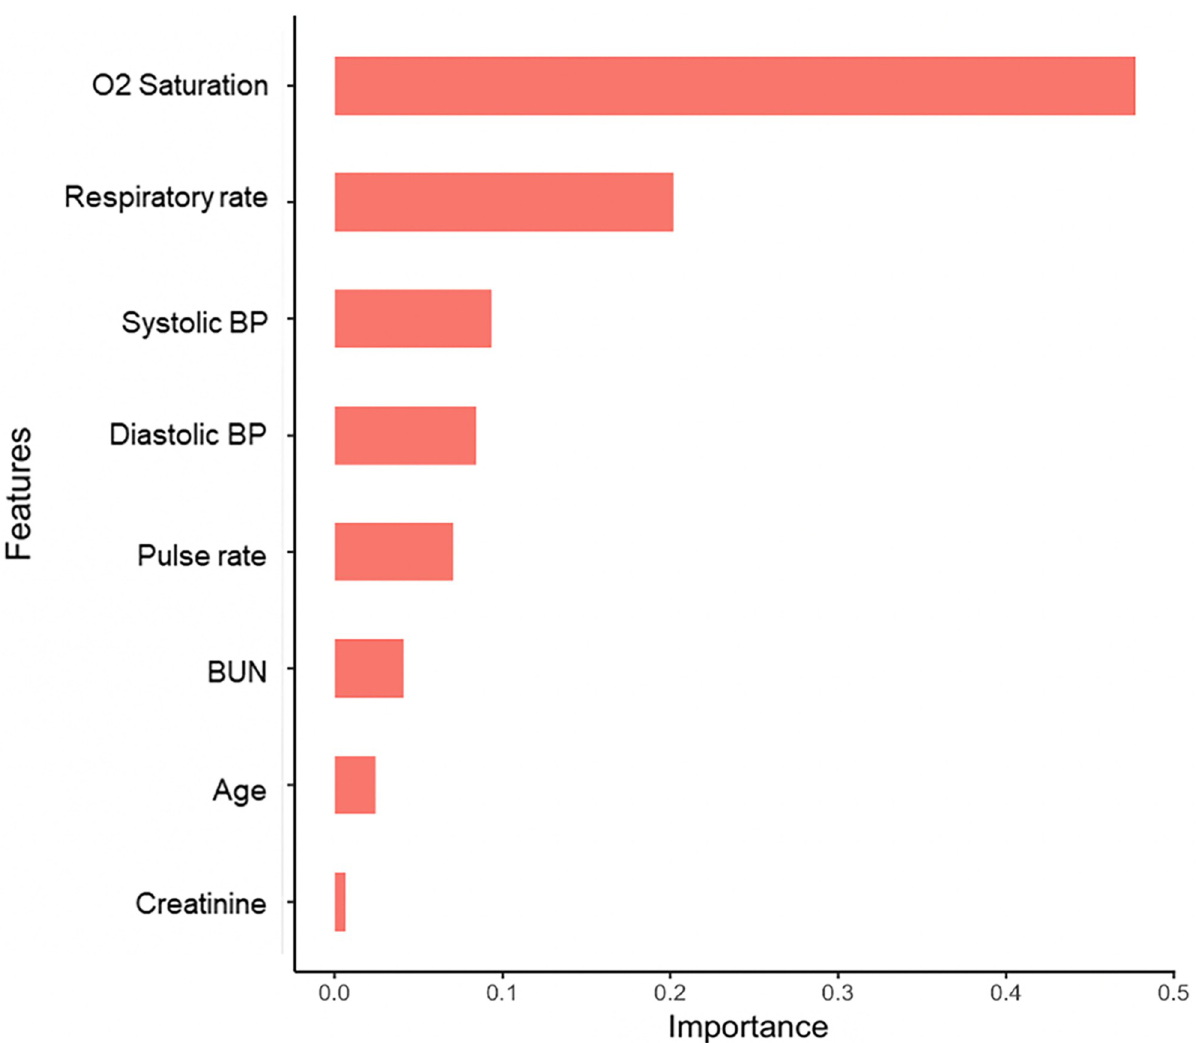
Fig 1. Features, or variables, identified by the XGBoost model and ranked by importance, based on the gain in the accuracy of classification when the variable was used in decision trees that generated the model.